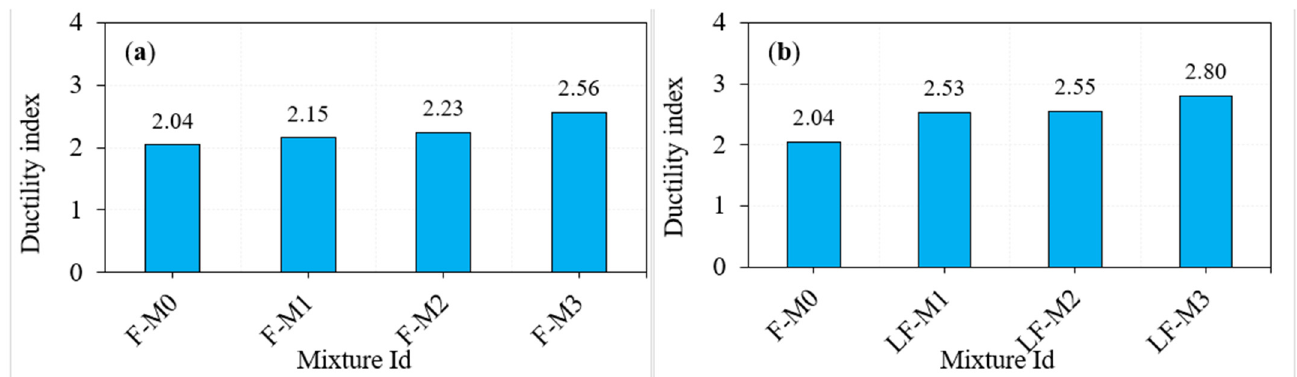
Figure 8. Ductility index. ( a ) Fibrous specimens and ( b ) layered fibrous.